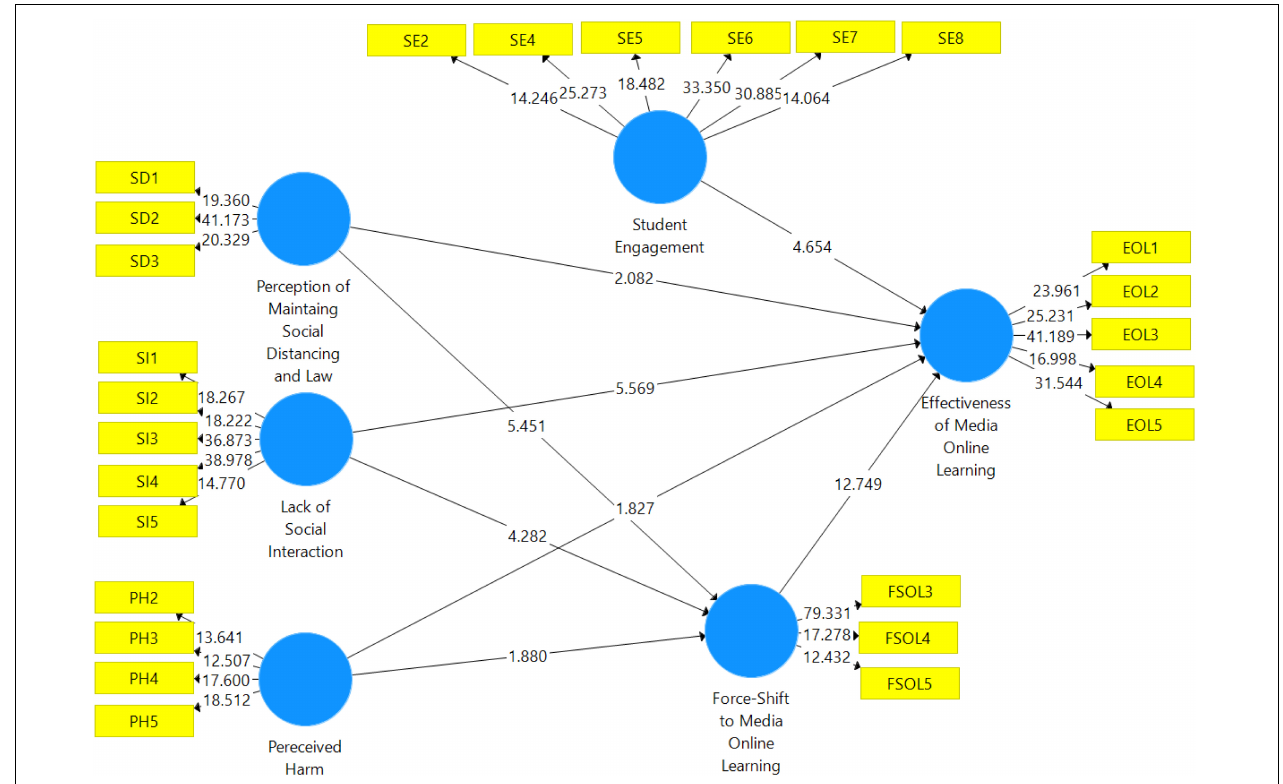
FIGURE 3 | Output of structural model